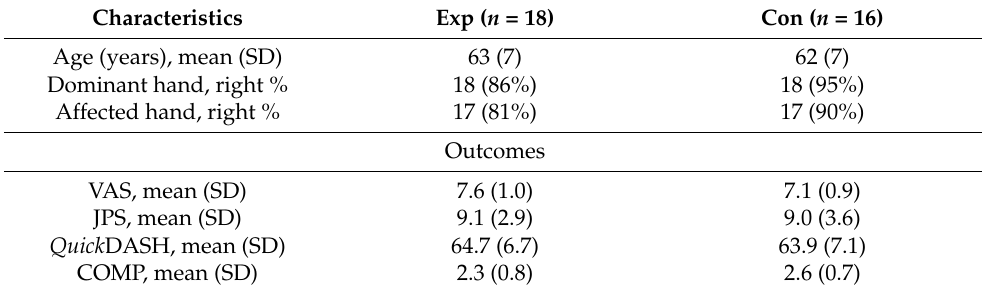
Table 1. Characteristics of patients at